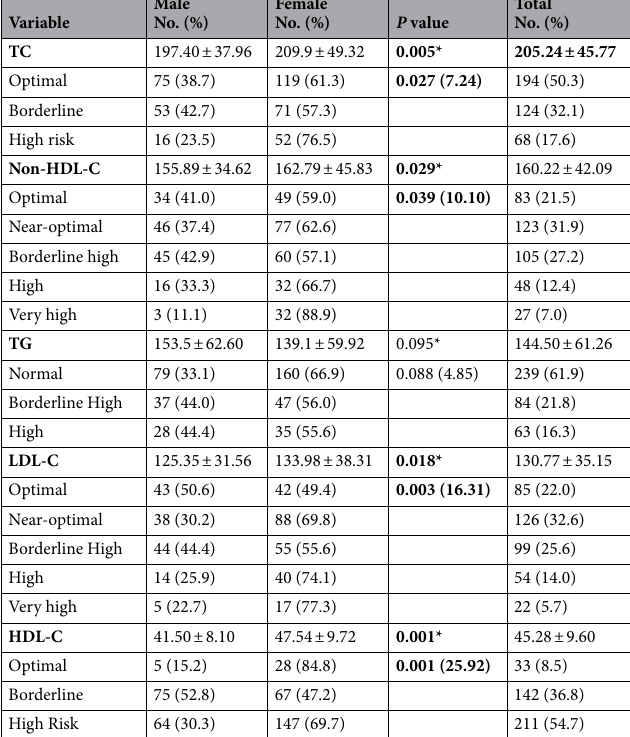
Table 3. Gender comparisons and NCEP ATP III risk categories. Significant values are in bold. LDL-C low- density lipoprotein, HDL-C high-density lipoprotein, TC total cholesterol, TG triacylglycerol. * t